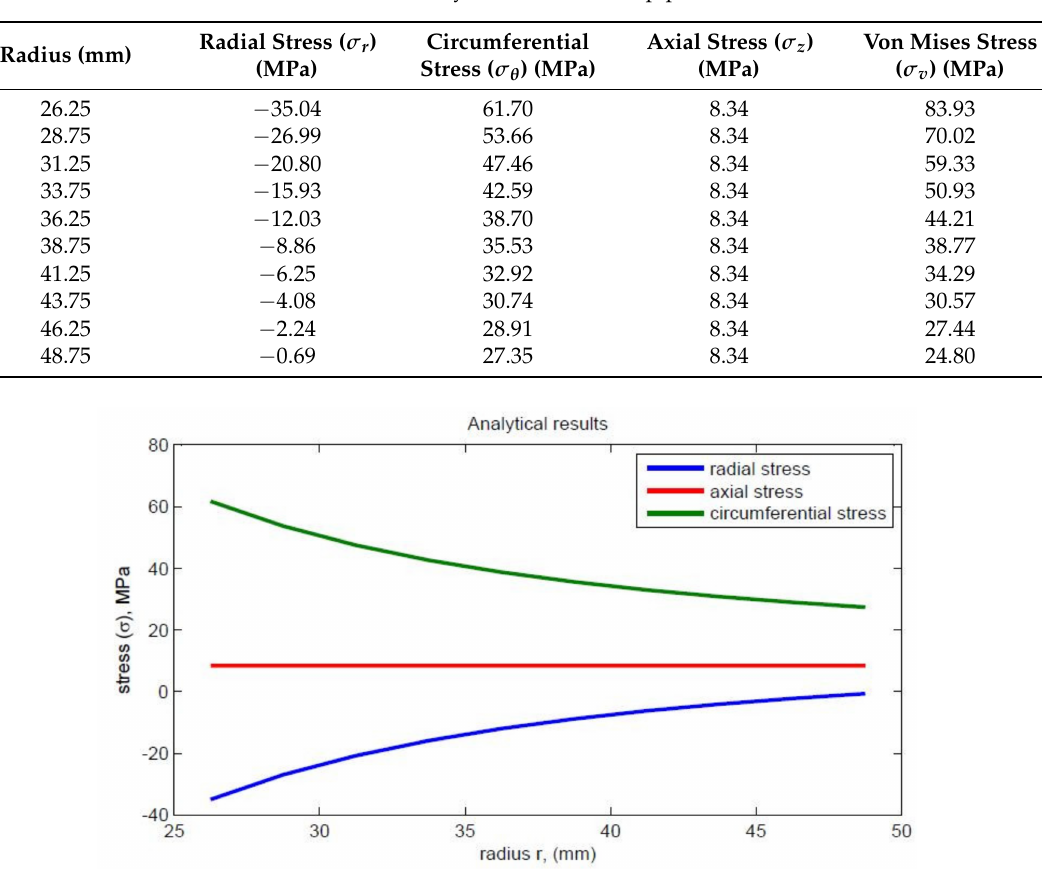
Table 1. Analytical results of the pipe.